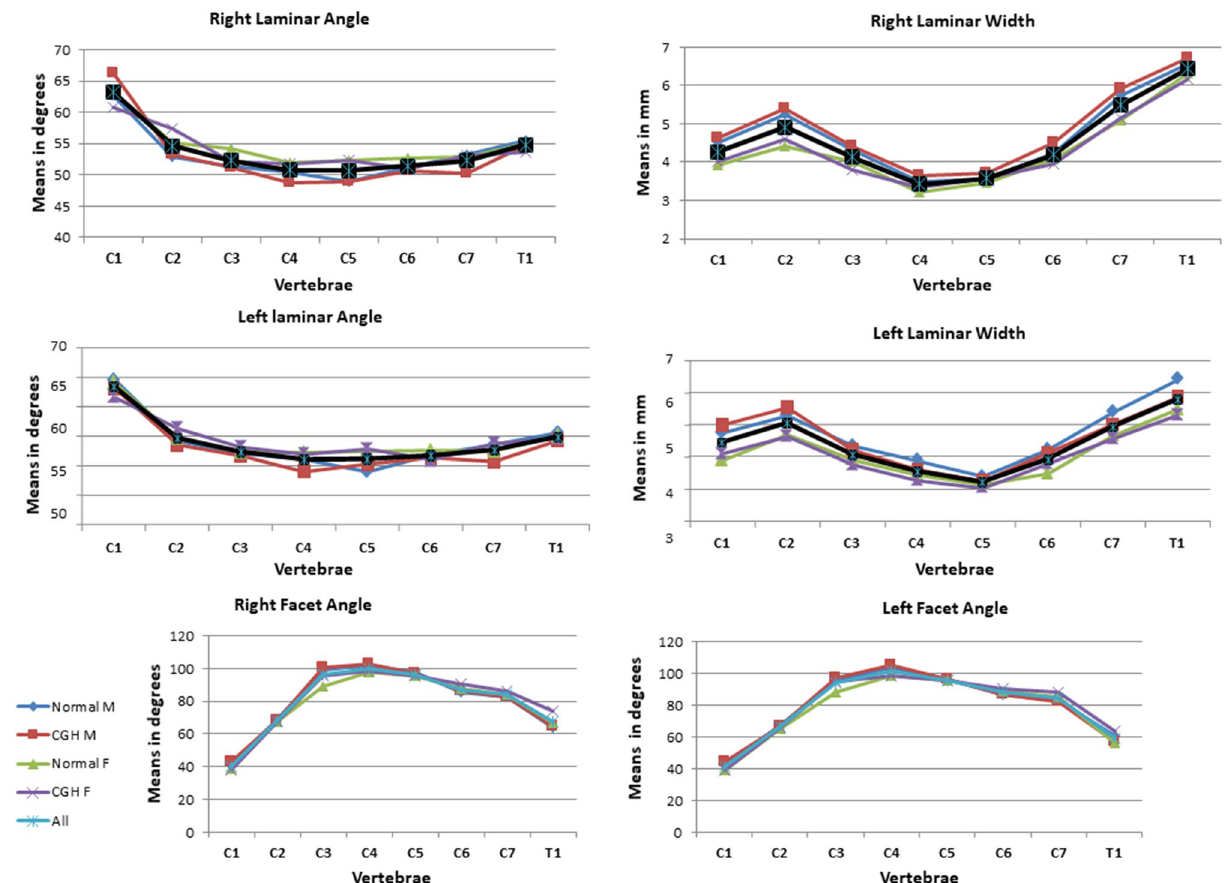
Figure 4. Lamina shape variation along the cervical spine . NM normal males, CEHM cervicogenic headaches males, NF Normal females, CEHF cervicogenic headaches females, All all individuals combined.